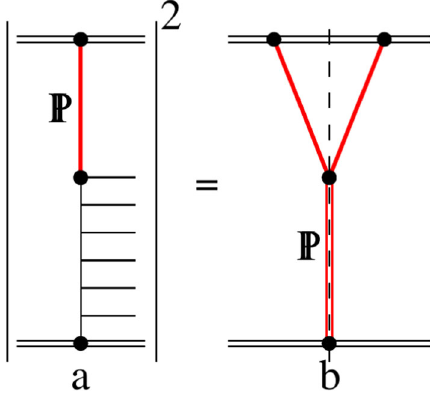
Fig. 1 Schematic diagrams of single diffractive (SD) processes in Pomeron–proton